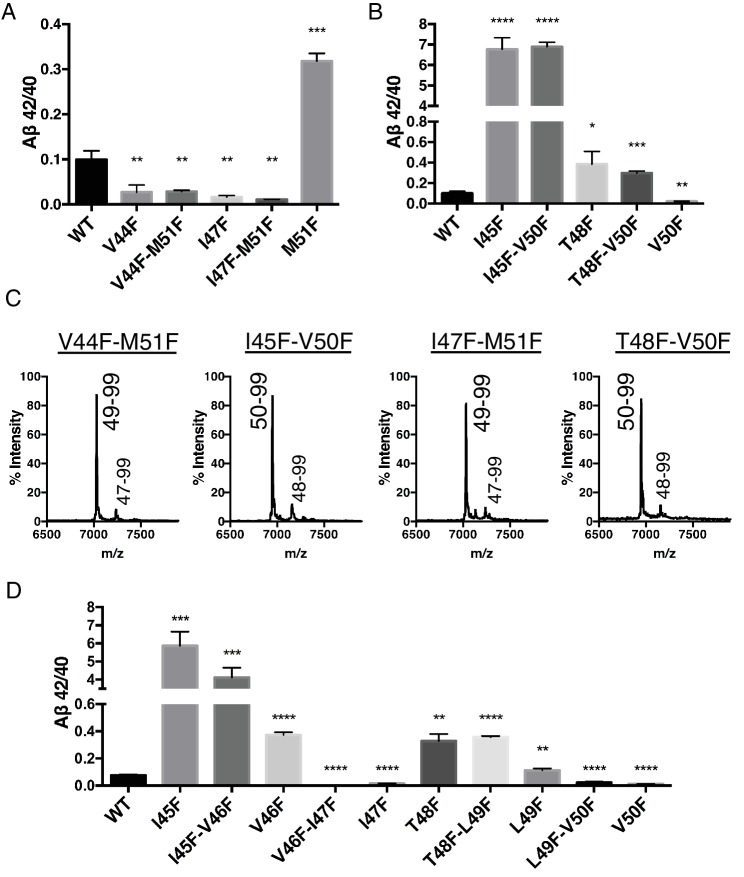
Phenylalanine mutations in the P2’ position of the last read tripeptide segment dictates final pathway preference.(A) Aβ42/40 ratios from HEK cells of V44F-M51F and I47F-M51F double mutants behave like single Phe mutants V44F and I47F, respectively. Aβ levels measured by 4G8 ELISA. Mean ± SD, n = 3, t-test **<0.01, ***<0.001. (B) Aβ42/40 ratios from HEK cells of I45F-V50F and T48F-V50F double mutants behave like single Phe mutants I45F and T48F, respectively. Aβ levels measured by 4G8 ELISA. Mean ± SD, n = 3, t-test *<0.05, **<0.01, ***<0.001, ****<0.0001. (C) MALDI/TOF MS conformation of the elimination of AICD 49–99 and AICD 50–99 for the V50F and M51F containing double Phe mutants, respectively. V44F-M51F (AICD 49–99, expected mass: 7034.8, observed mass: 7030.7; AICD 47–99 expected mass: 7249.0, observed mass: 7253.7), I45F-V50F (AICD 50–99, expected mass: 6953.8, observed mass: 6950.1; AICD 48–99, expected mass: 7167.9, observed mass: 7164.6), I47F-M51F (AICD 49–99, expected mass: 7034.8, observed mass: 7032.2; AICD 47–99, expected mass: 7283.0, observed mass: 7280.1), T48F-V50F (AICD 50–99, expected mass: 6953.8, observed mass: 6949.4; AICD 48–99, expected mass: 7214.0, observed mass: 7209.4). (D) Aβ42/40 ratios from HEK cells transfected with double Phe mutations in tandem. Aβ levels measured by 6E10 ELISA. Mean ± SD, n = 3, t-test **<0.01, ***<0.001, ****<0.0001.